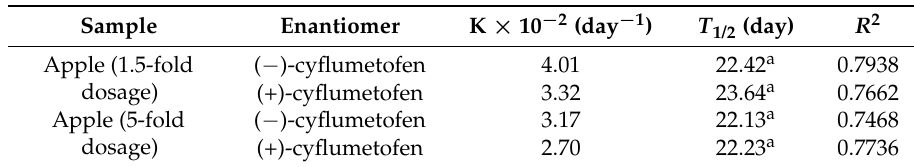
Table 2. Degradation kinetic constant (k), Half-life ( T 1/2 ) and correlation coefficient ( R 2 ) values of cyflumetofen in apple.